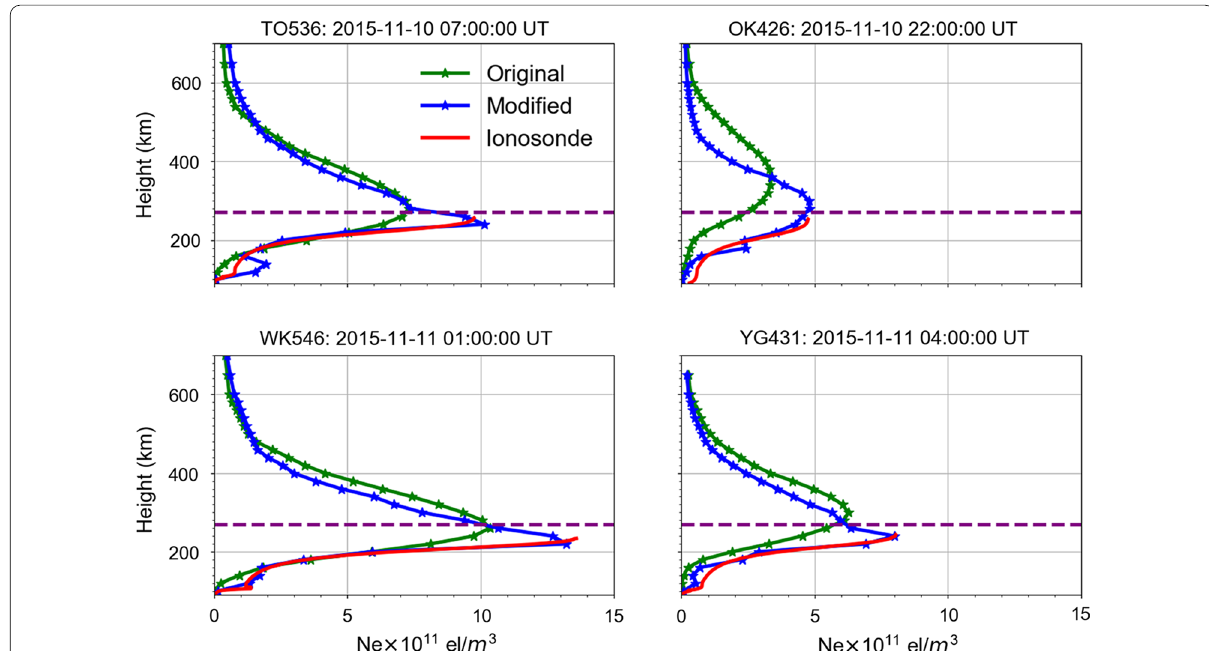
Fig. 2 Examples of density profiles reconstructed at different ionosonde locations in Japan. The time stamps are indicated at the top of each subplot. The original tomography densities without the assimilation complexity are shown in green. Eminent is the robustness of the modified version (blue) to track the ionosonde measured (red) densities below the 270 km altitude range (purple line)